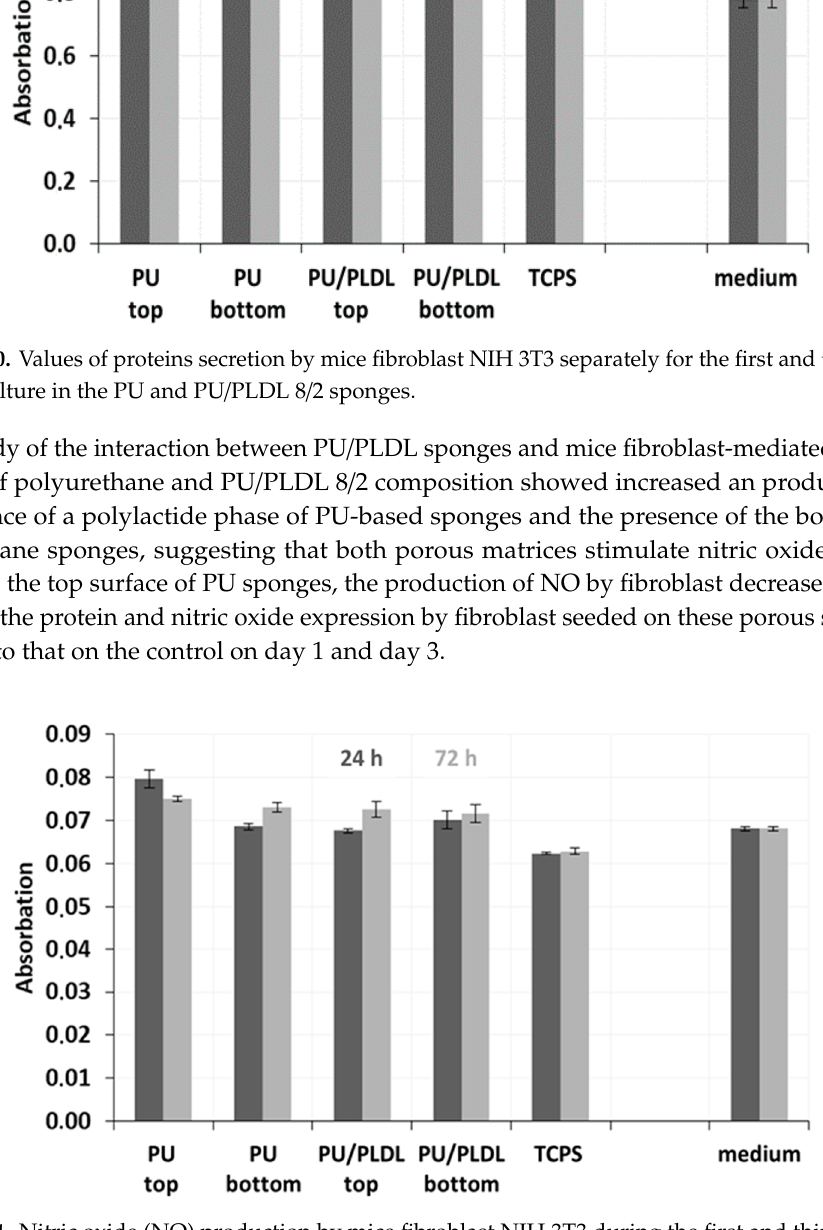
Figure 9. SEM micrographs of fibroblasts NIH 3T3 on the polyurethane ( a , c ), and